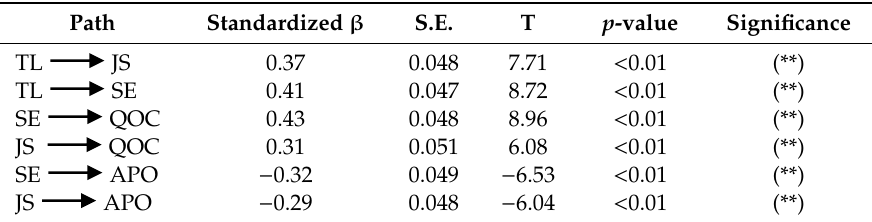
Table 5. β coe ffi cients for testing hypotheses 1–6. Table 5. β coefficients for testing hypotheses 1–6. Table 5. β coefficients for testing hypotheses 1–6. Table 5. β coefficients for testing hypotheses 1–6. Table 5. β coefficients for testing hypotheses 1–6. Table 5. β coefficients for testing hypotheses 1–6. Table 5. β coefficients for testing hypotheses 1–6.